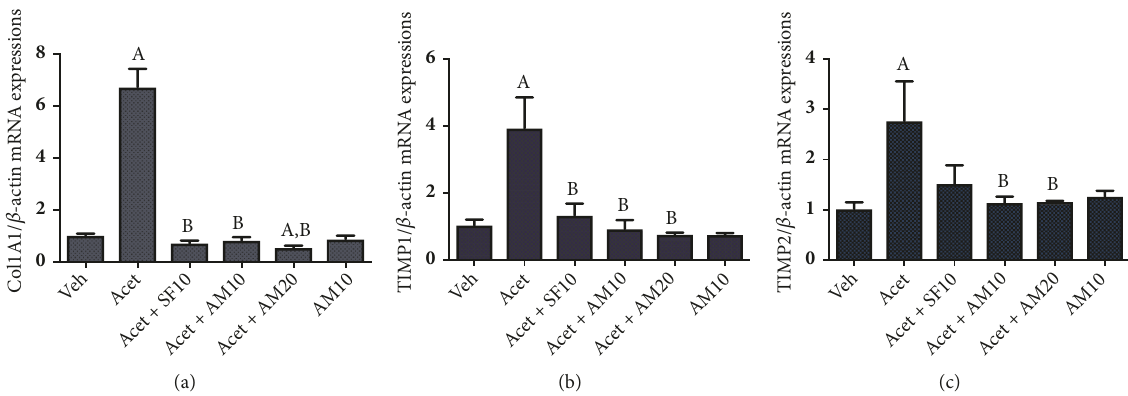
Figure 5: Effect of alpha mangostin on profibrogenic markers as shown by mRNA expressions of (a) Col1A1/ 𝛽 -actin, (b) TIMP1/ 𝛽 -actin, and (c) TIMP2/ 𝛽 -actin, after LX-2 cells were treated with alpha mangostin with or without acetaldehyde induction. Results were presented as mean ± SEM. A: p < 0.05 versus untreated group, B: p < 0.05 versus acetaldehyde group. Veh: vehicle only, Acet: acetaldehyde 100 𝜇 M, Acet + SF10: acetaldehyde 100 𝜇 M + sorafenib 10 𝜇 M, Acet + AM10: acetaldehyde 100 𝜇 M + alpha mangostin 10 𝜇 M, Acet + AM20: acetaldehyde 100 𝜇 M + alpha mangostin 20 𝜇 M, AM 10: alpha mangostin 10 𝜇 M.